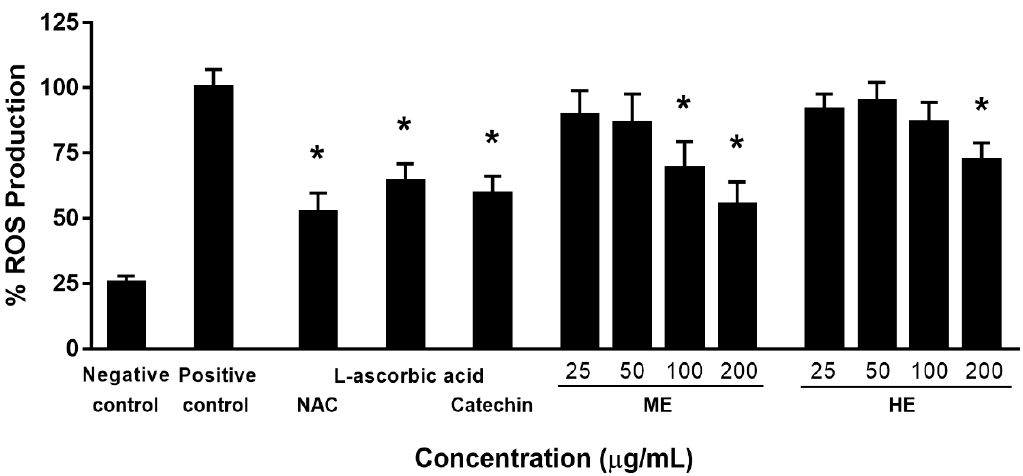
Figure 1. The effects of C. japonica seed coat extracts on H 2 O 2 -induced intracellular reactive oxygen species (ROS) production in peripheral blood mononuclear cells (PBMCs). Untreated cells were used as a negative control. N -acetylcysteine (NAC, 80 µM), L-ascorbic acid (250 µM), and catechin (125 µM) were used as positive controls. * Data represent the mean ± SD of three independent experiments. p < 0.05 versus positive control. ME: methanolic extract, and HE: hexane extract.